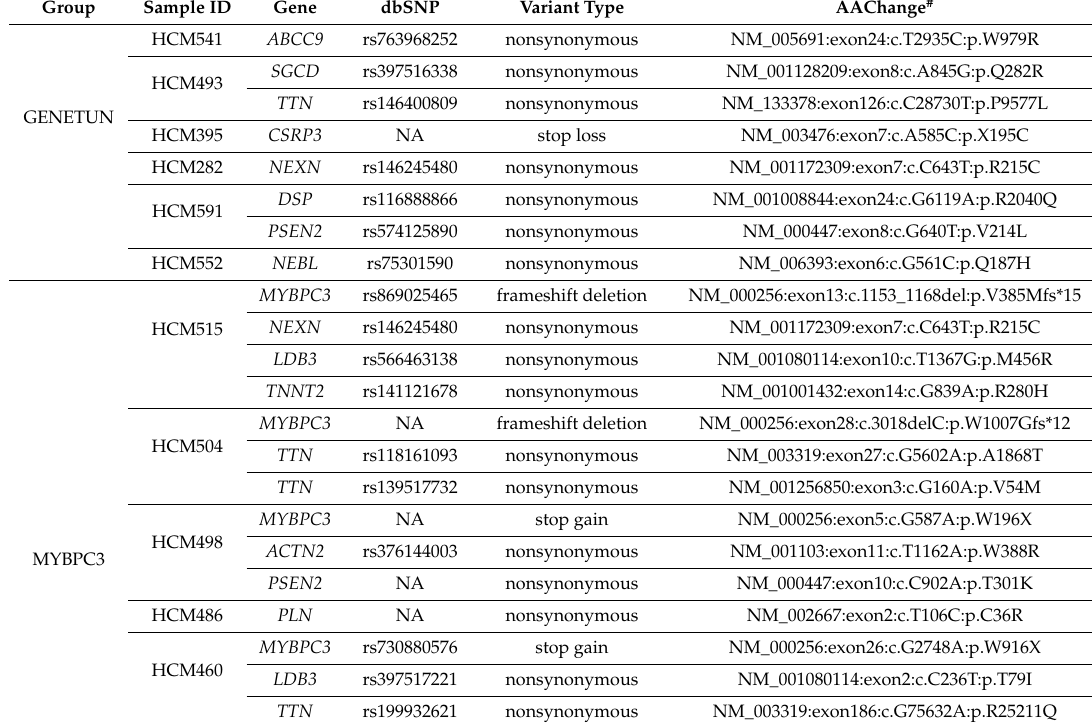
Figure 2. Heatmap of the pathogenic genes across hypertrophic cardiomyopathy (HCM) patients. Red rectangles represent HCM patients (rows) who carry pathogenic variant(s) in the corresponding gene(s) (columns). Table 3. Lists of candidate variants prioritized from HCM patients.